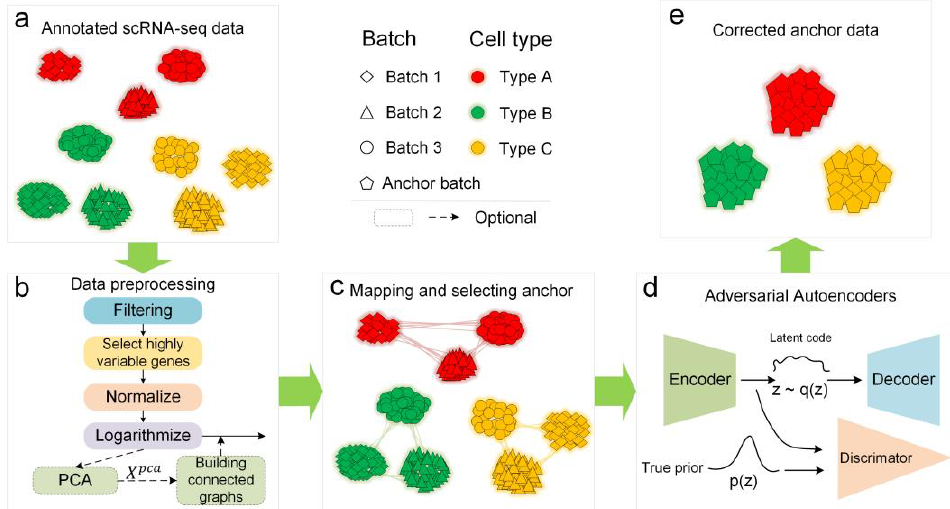
Figure 2. The overall description of the proposed IMAAE framework. ( a ) Get the annotated scRNA- seq dataset. ( b ) Data preprocessing. ( c ) Establish mapping relationships for different batches of the same type of cells and select the anchor batch. ( d ) The preprocessed data is fed to the adversarial autoencoder for training according to the mapping relationship. ( e ) Batch effects are corrected using a trained adversarial autoencoder .